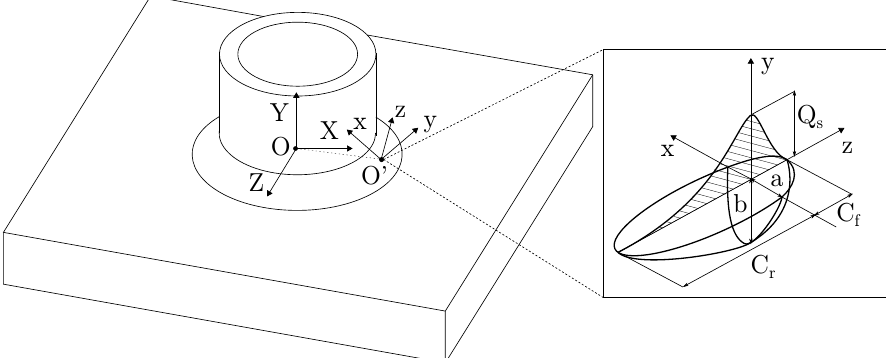
Figure 5. Coordinate system transformation between global and local reference frame, for Goldak’s double-ellipsoid model.